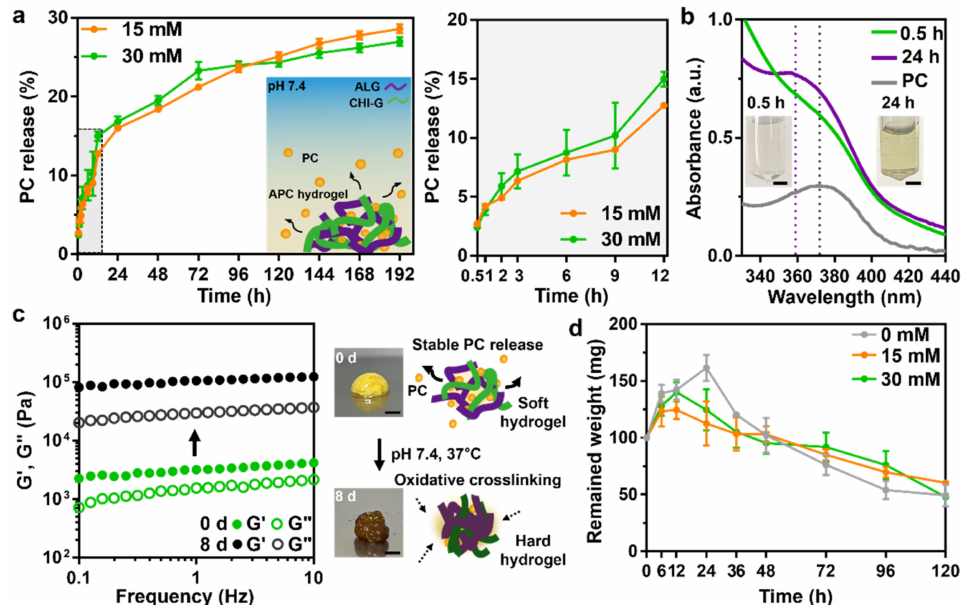
Figure 4. ( a ) PC release kinetics of 15 mM (orange) and 30 mM (green) APC hydrogels ( left ) and their initial release profile observed within 12 h ( right ) ( n = 3). ( b ) UV-Vis spectra of the released eluents from the hydrogels at 0.5 h (green) and 24 h (violet) and PC alone (gray), and photos of their eluents. Scale bar: 5 mm. The dashed lines for the wavelength of 359 nm and 372 nm. ( c ) Rheological properties of the APC hydrogels with 30 mM incubated for 0 (green) or 8 d (black). Filled symbols for storage modulus (G (cid:48) ) and open symbols for loss modulus (G”). The photos indicate colorimetric changes of the APC hydrogels during incubation and schematic illustration shows oxidation of PC as time went by. Scale bar: 5 mm. ( d ) Degradation profile of APC hydrogels (0 mM (gray), 15 mM(orange), and 30 mM (green)) ( n = 3). All statistical significance and p values are determined by one-way ANOVA followed by Tukey’s post-hoc test.